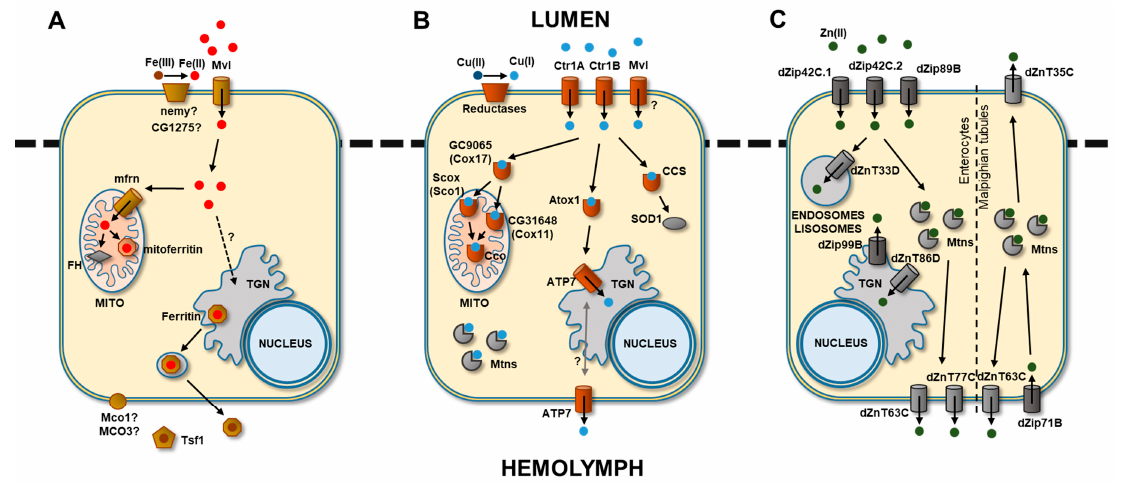
Figure 1. Main pathways of ( A ) iron, ( B ) copper and ( C ) zinc uptake, storage and export in Drosophila melanogaster . TGN, trans-Golgi network; MITO, mitochondria. Question marks represent an unknown mechanism. Arrows represent the direction of the metal transport.